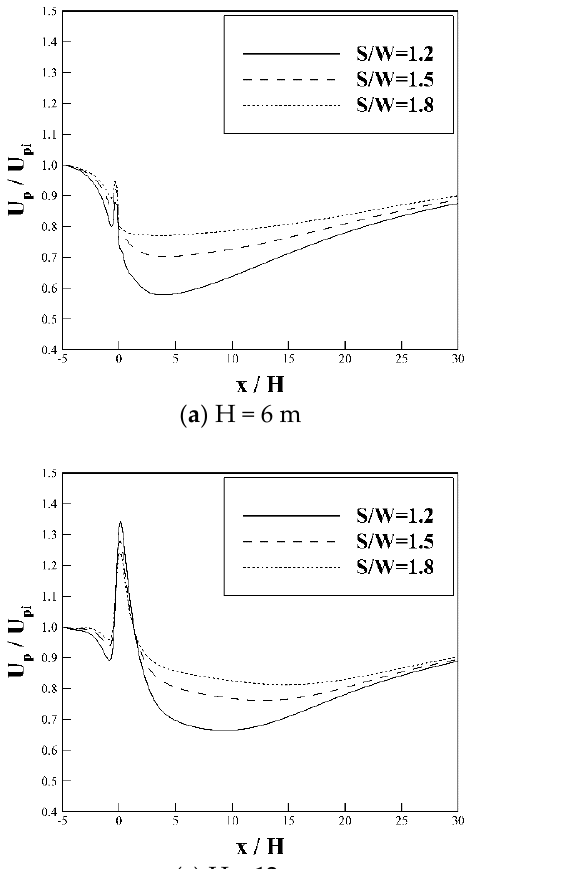
Figure 14. Stream-wise variations of averaged pedestrian wind speeds at different tree heights. By examining the magnitudes of the maximum pedestrian wind speeds at different tree heights and spaces, Figure 15 shows that the magnitude of the local wind speed max- ima appears insensitive to the change of the tree distance when H = 6 m. When the trees are taller, however, the value of the maximum wind speed becomes greater as the tree height increases or the tree space decreases. On the other hand, Figure 16 illustrates the locations and magnitudes of the downstream minimum pedestrian wind speeds. In the cases of 6 m tree height, the location of minimum wind speed appears nearly independent of the tree space. When the tree becomes taller, the minimum value occurs further down- stream with increases of the tree height and tree space. Meanwhile, the magnitude of the